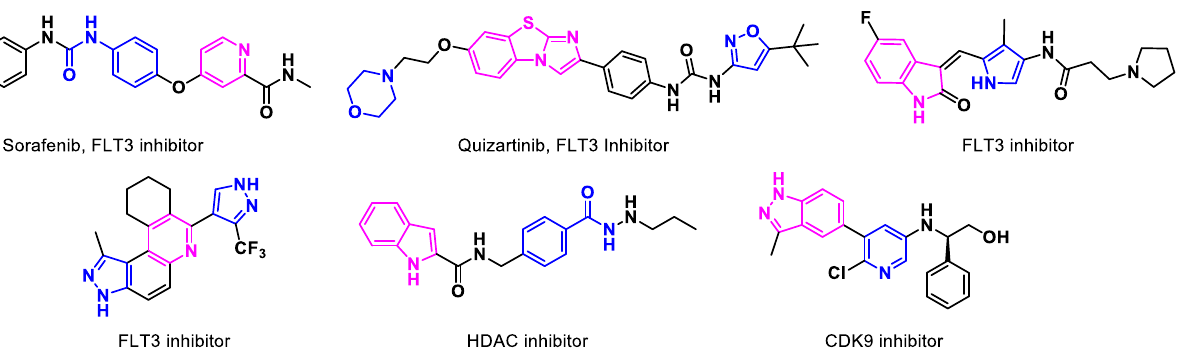
Figure 2. Non-approved small molecule inhibitors for acute myeloid leukemia (AML). In addition to the FDA-approved drugs, some other FLT3 inhibitors are currently in clinical trials. Sorafenib is a multi-targeted tyrosine kinase inhibitor, and quizartinib is a specific FLT3 inhibitor. These have not been approved by the FDA for use in AML. Abbreviations: FLT3: FMS-like tyrosine kinase 3; HDAC: histone deacetylase; CDK9: cyclin dependent kinase 9.